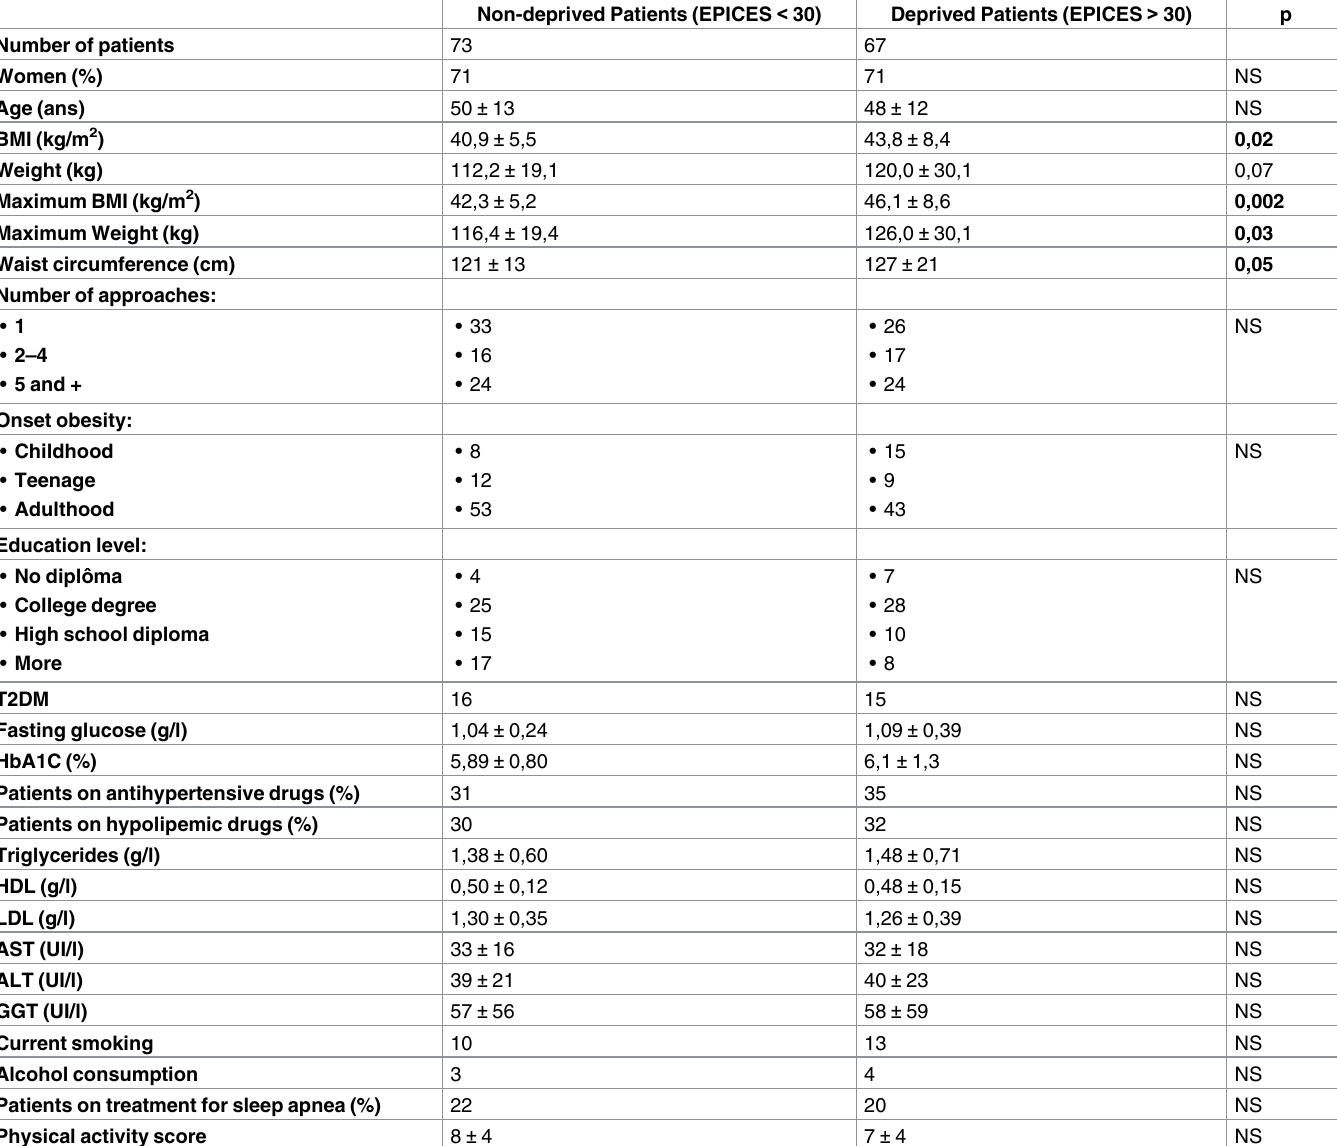
Table 1. Characteristics of non-deprived patients suffering from obesity (N = 73) versus deprived ones (N = 67). Non-deprived Patients (EPICES < 30) Deprived Patients (EPICES >